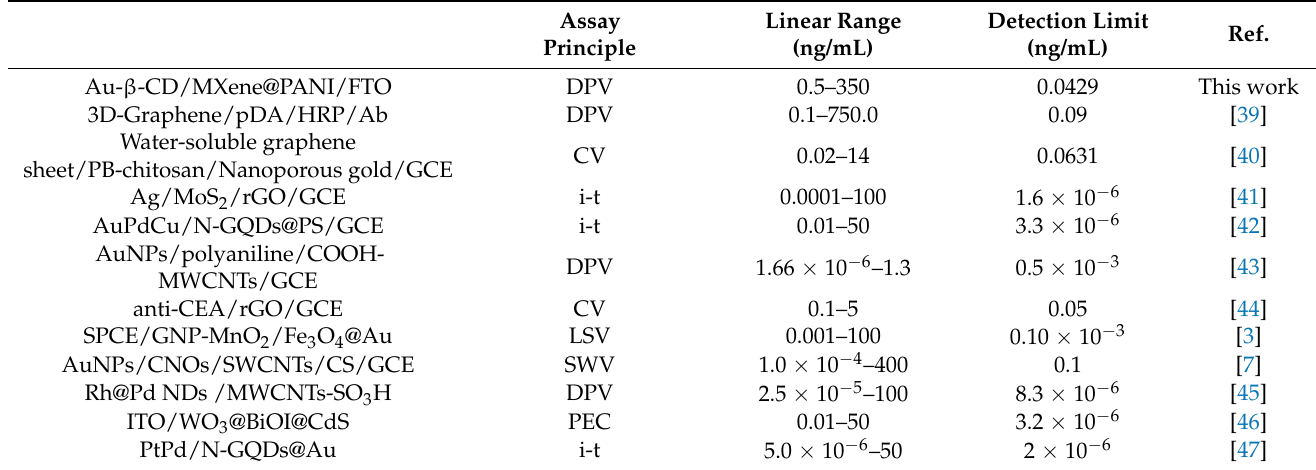
Table 1. Comparison of linear range and detection limit of various CEA immunosensors. Assay Linear Range Detection Limit Ref. Principle (ng/mL) (ng/mL) DPV 0.5–350 0.0429 This